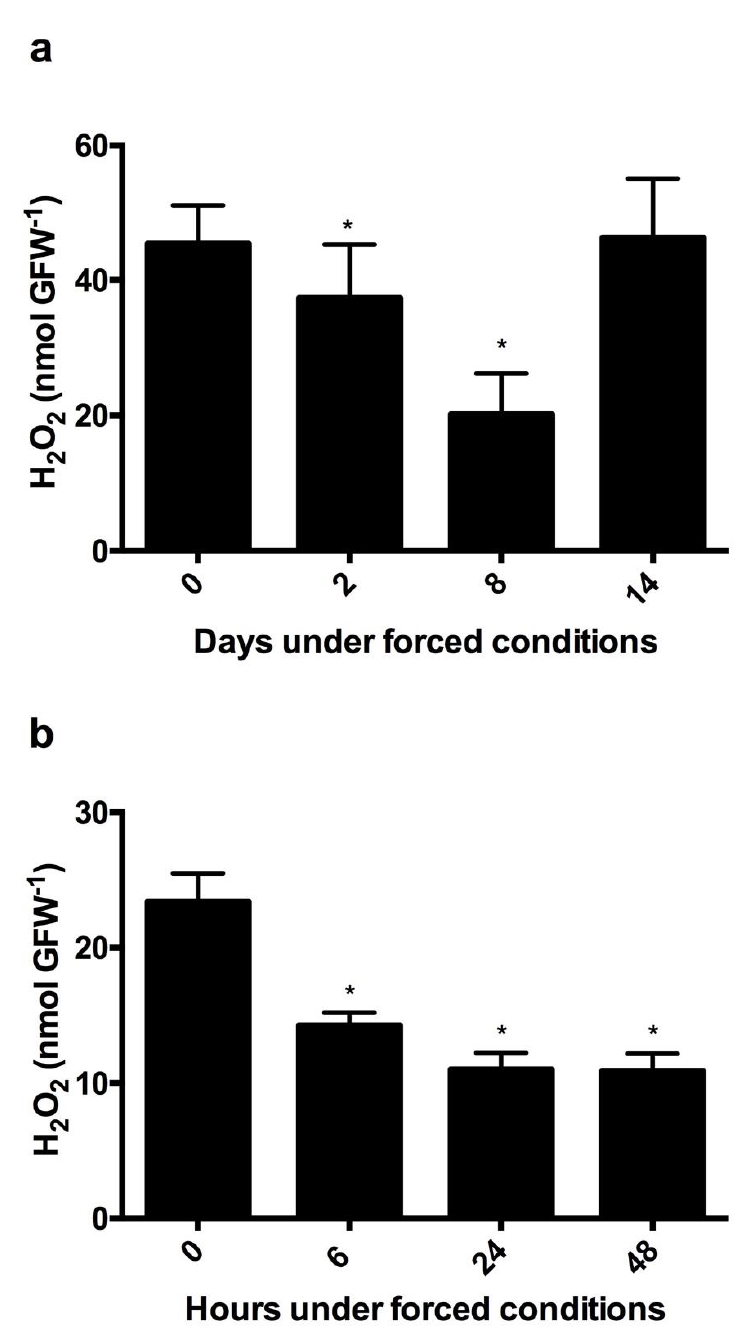
Figure 6. Rate of H 2 O 2 reduction in dormant and quiescent grapevine buds under forcing budbreak. Decreases in H 2 O 2 content in ( a ) endodormant and ( b ) quiescent buds of Thompson seedless grapevines under forced growth conditions. H 2 O 2 was determined by a chemiluminescence method [29]. Values are the average of three biological replicates ± SD; (*) indicates statistically significance differences .Student’s test (α = 0.05).